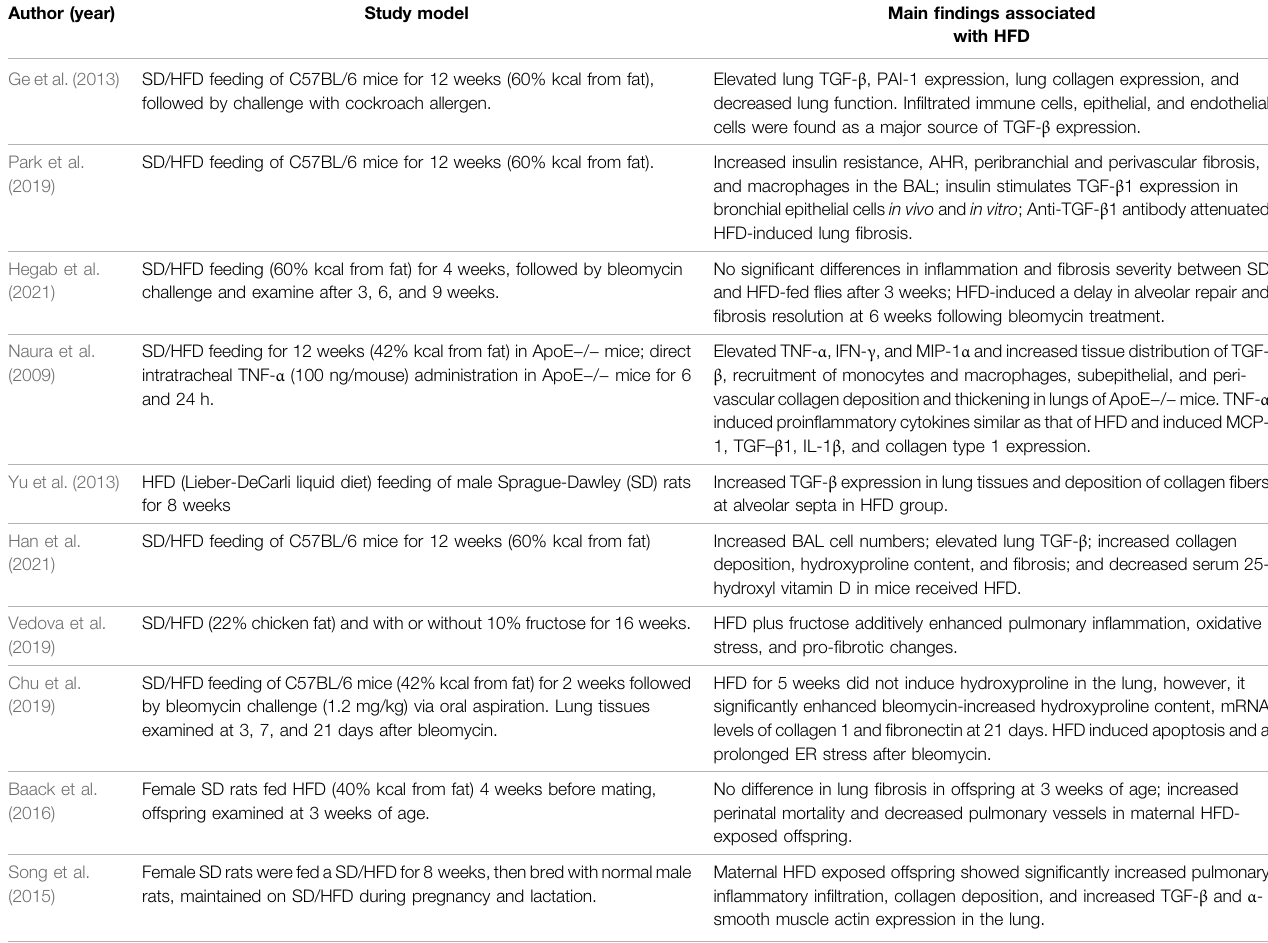
TABLE 1 | Summary of studies linking obesity and pulmonary fi